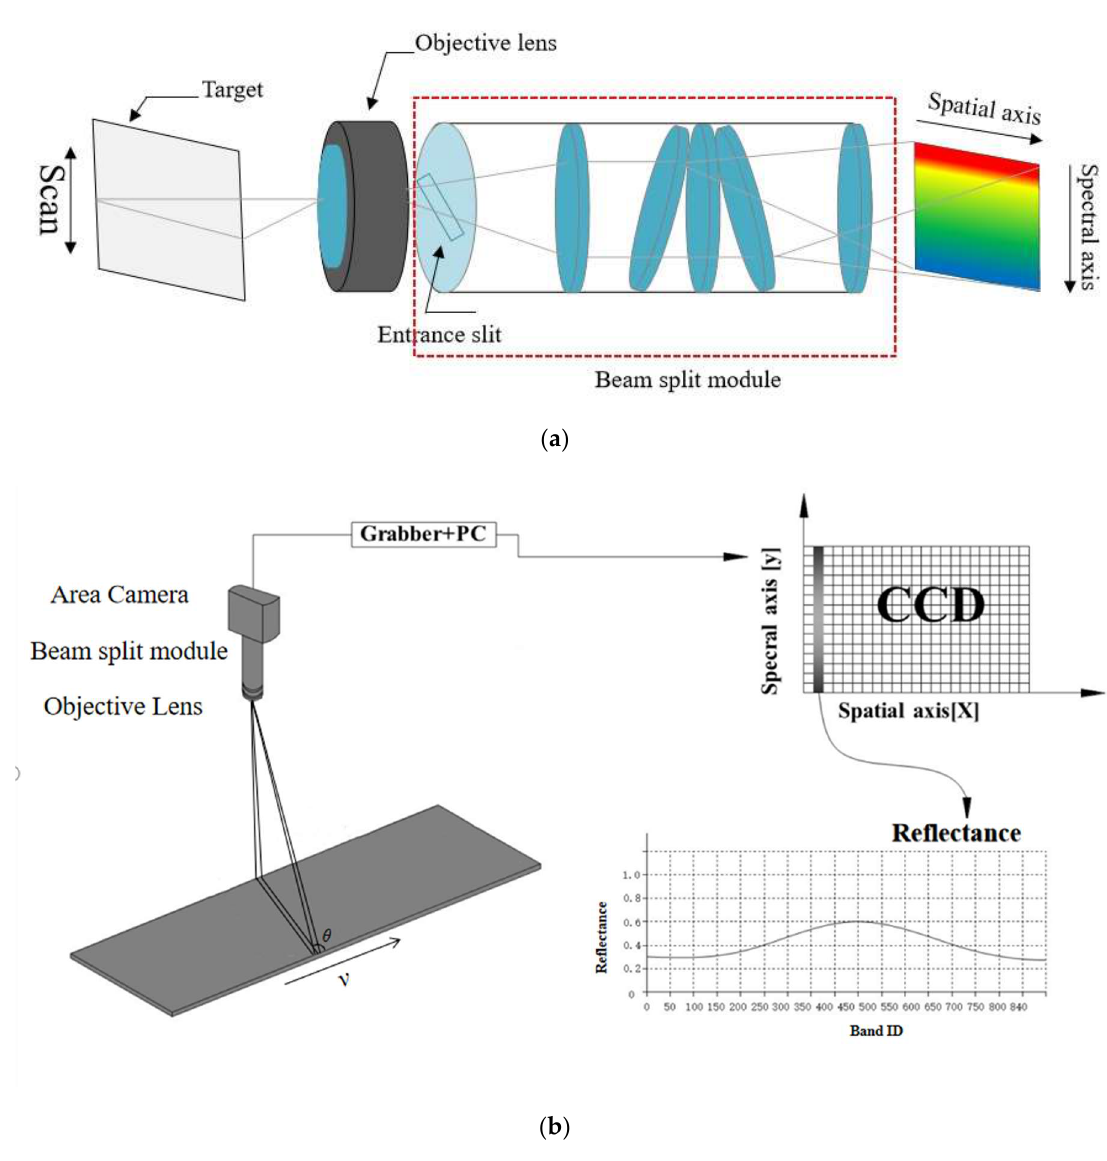
Figure 2. ( a ) Imaging principle of the sensor we used; ( b ) sampling diagram of the sensor we used. In Table 1, S / N means the signal-noise Table 1. Parameters of the Sensor.